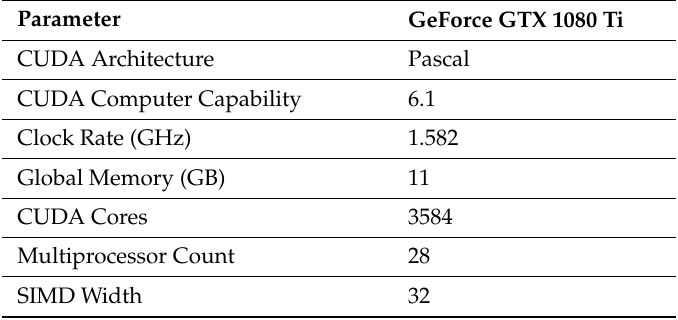
Table 1. Graphics processing unit (GPU) Specifications.